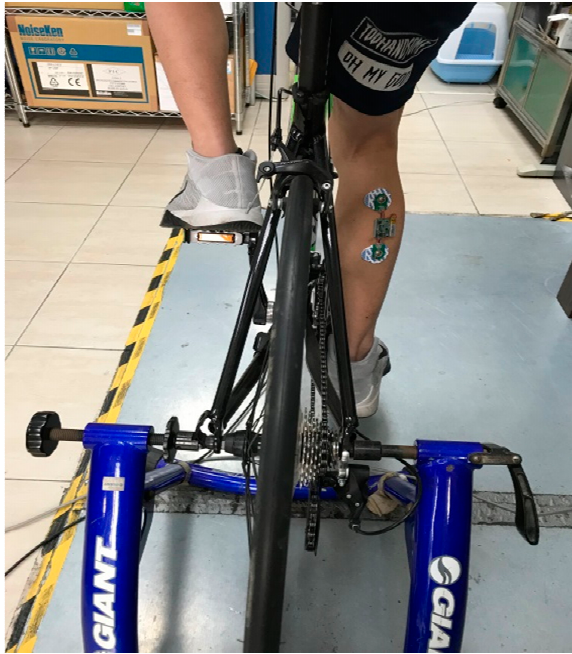
Figure 7. A photo of the experimental EMG patch.